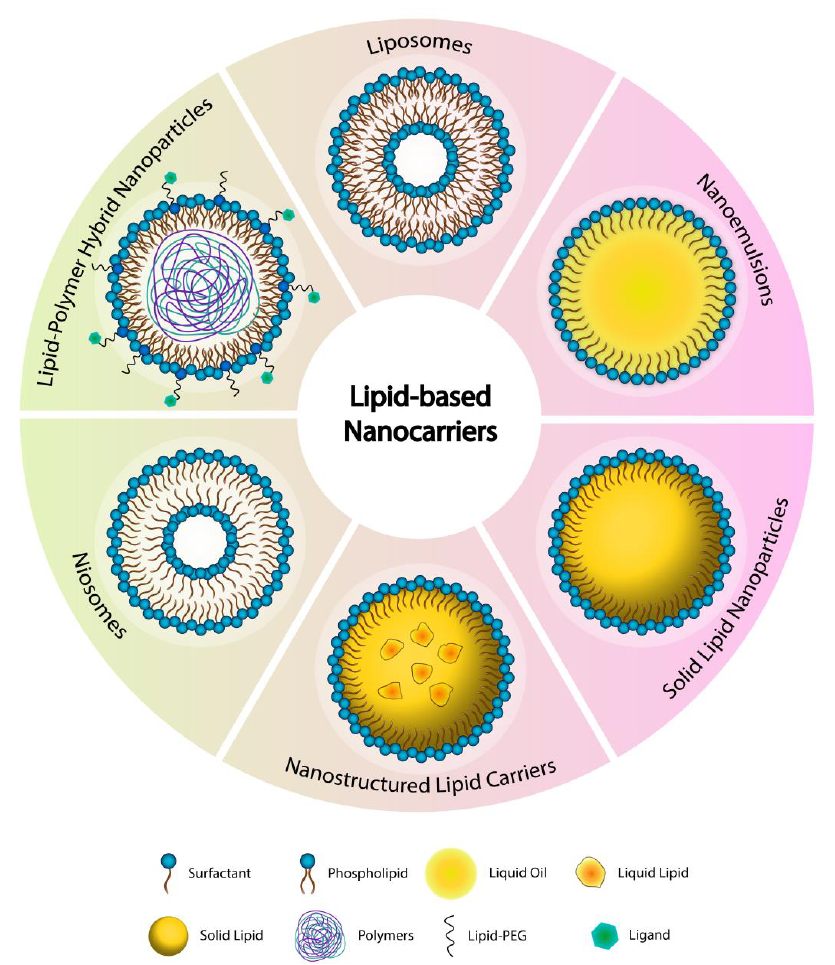
Figure 2. The various types of the lipid-based nanocarriers.